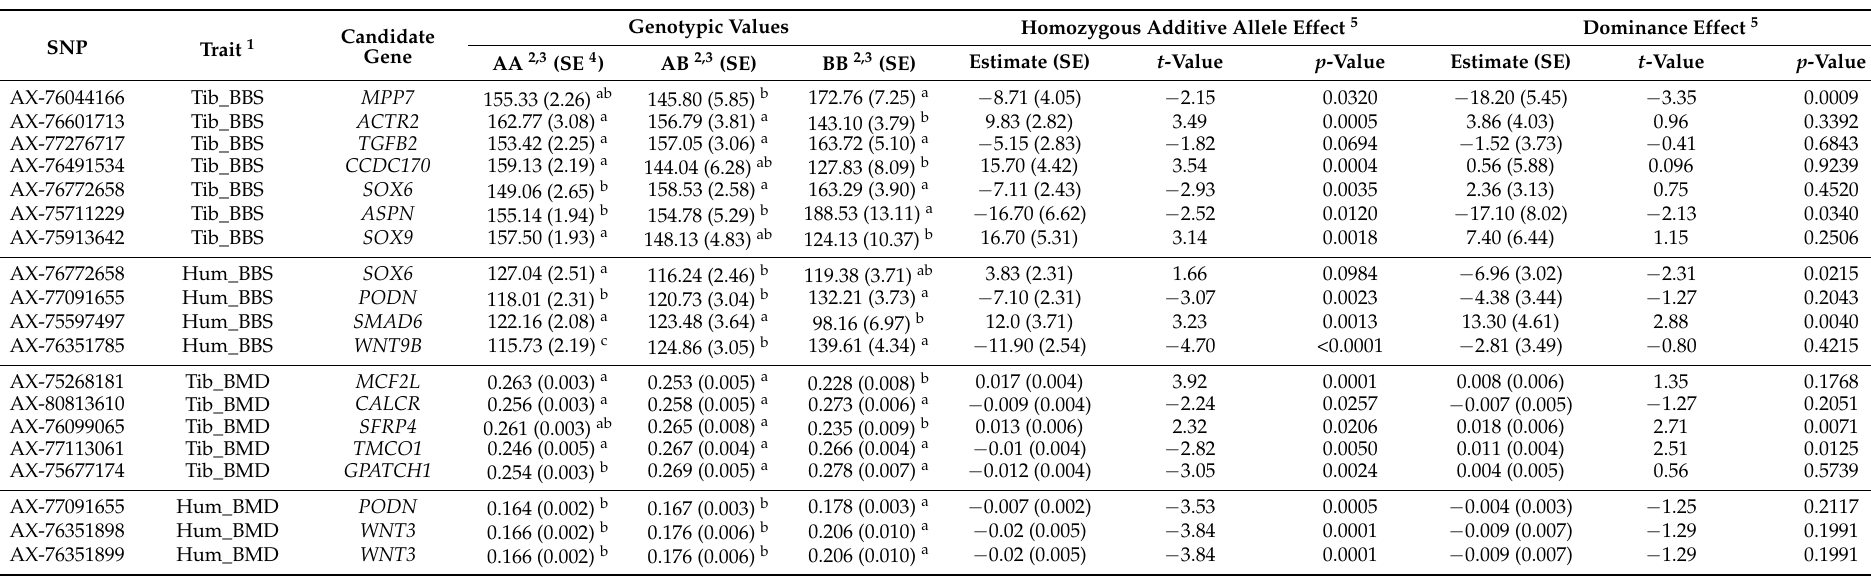
Table 3. SNP effects analysis—Part 2: Genotypic values (least squares means) and additive and dominance effects obtained from the dominant-recessive